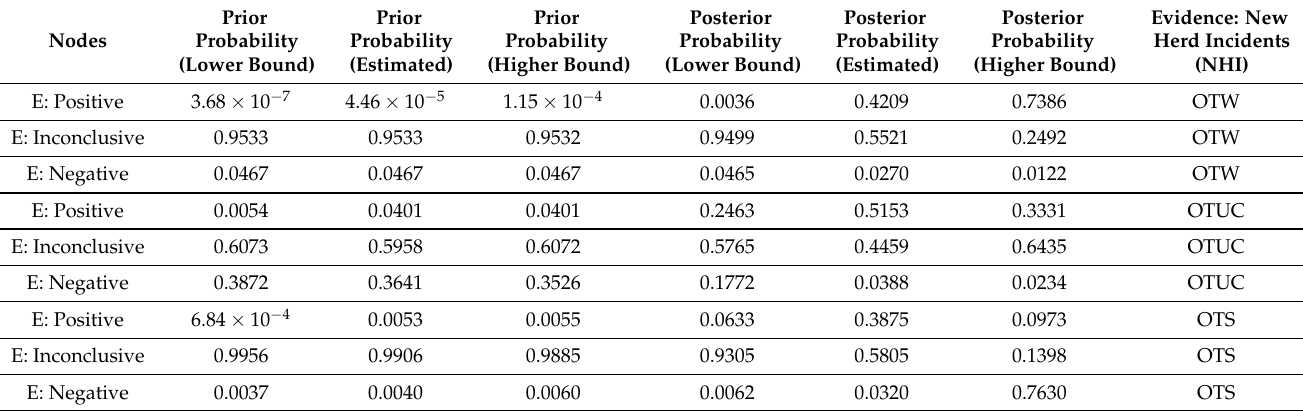
Table 10. Prior and posterior probabilities for node E in high-risk areas of England cattle farms. Nodes